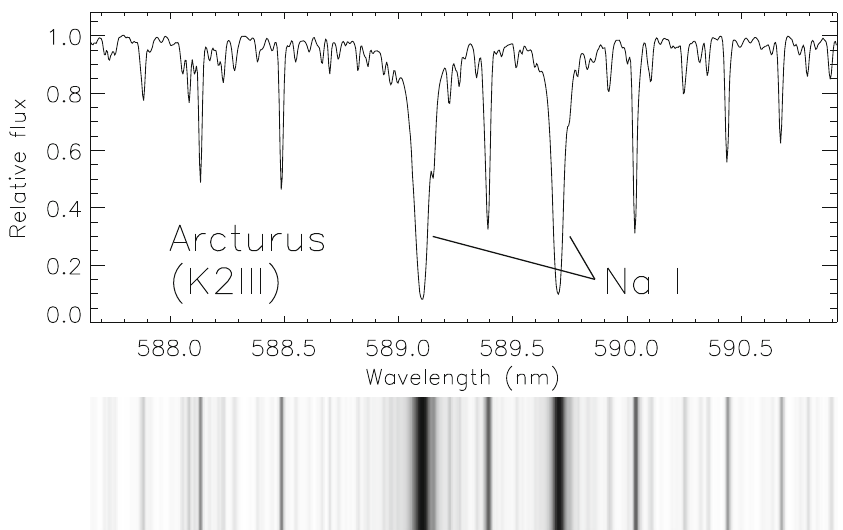
Fig. 2 A small section of a high resolution spectrum of the red giant Arcturus, the nearest giant at merely 11pc from us. The strongest transitions in this spectral window are the Na i D doublet atmospheric layers, imprinting dark stripes, absorption lines, in the spectrum, as illus- trated in